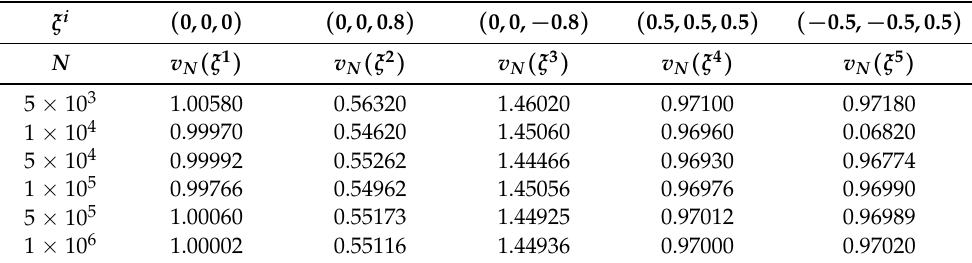
Table 4. Results for the Problem 2 (in Example 2).